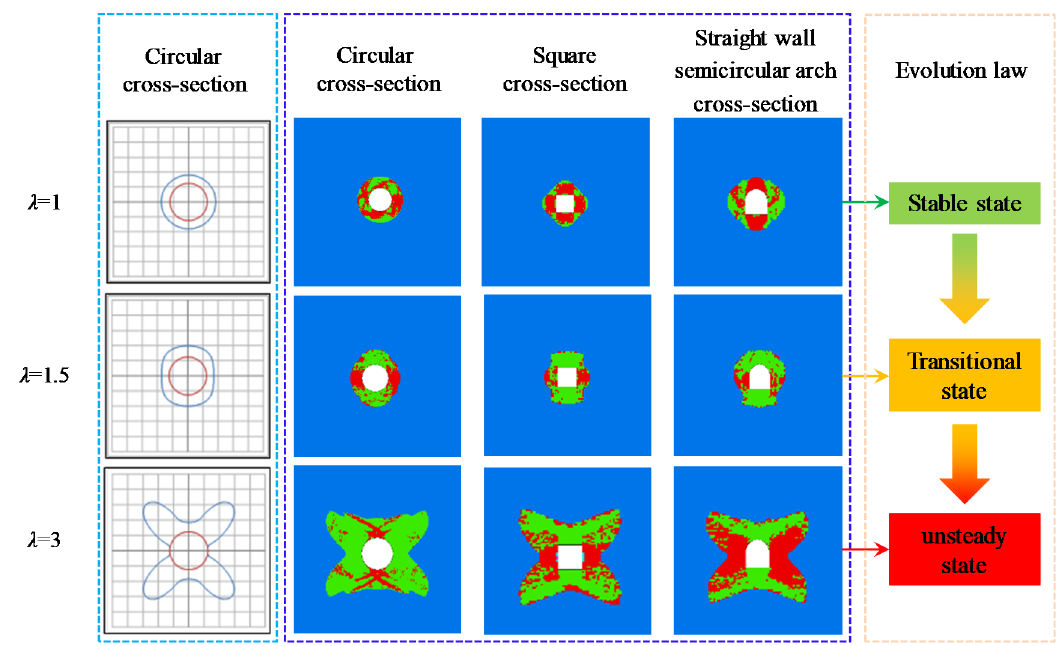
Figure 8. Evolution of the rock failure patterns surrounding the roadway.